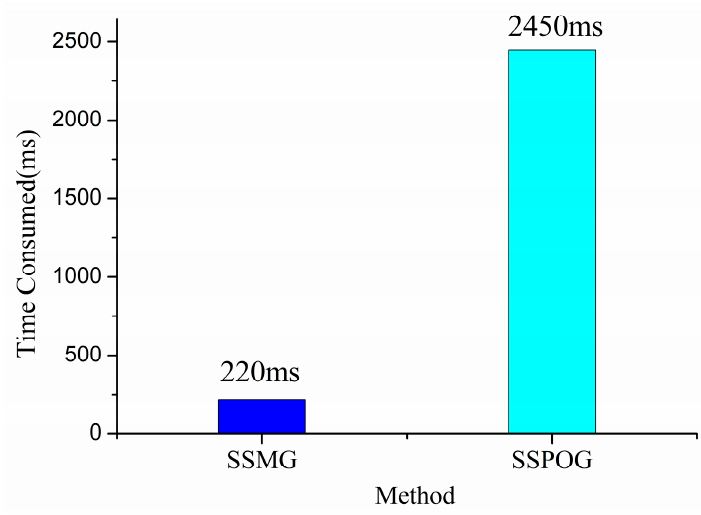
Figure 9. Time consumed for retrieval using SSMG and SSPOG.